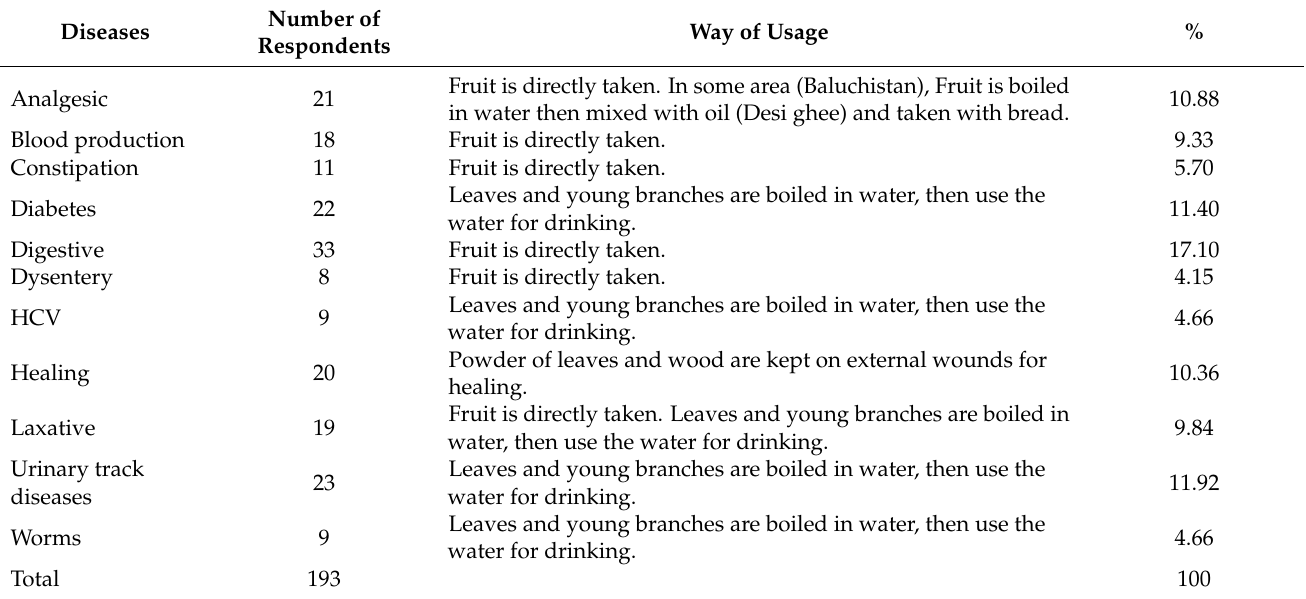
Table 9. Medicinal uses of Monotheca products by local